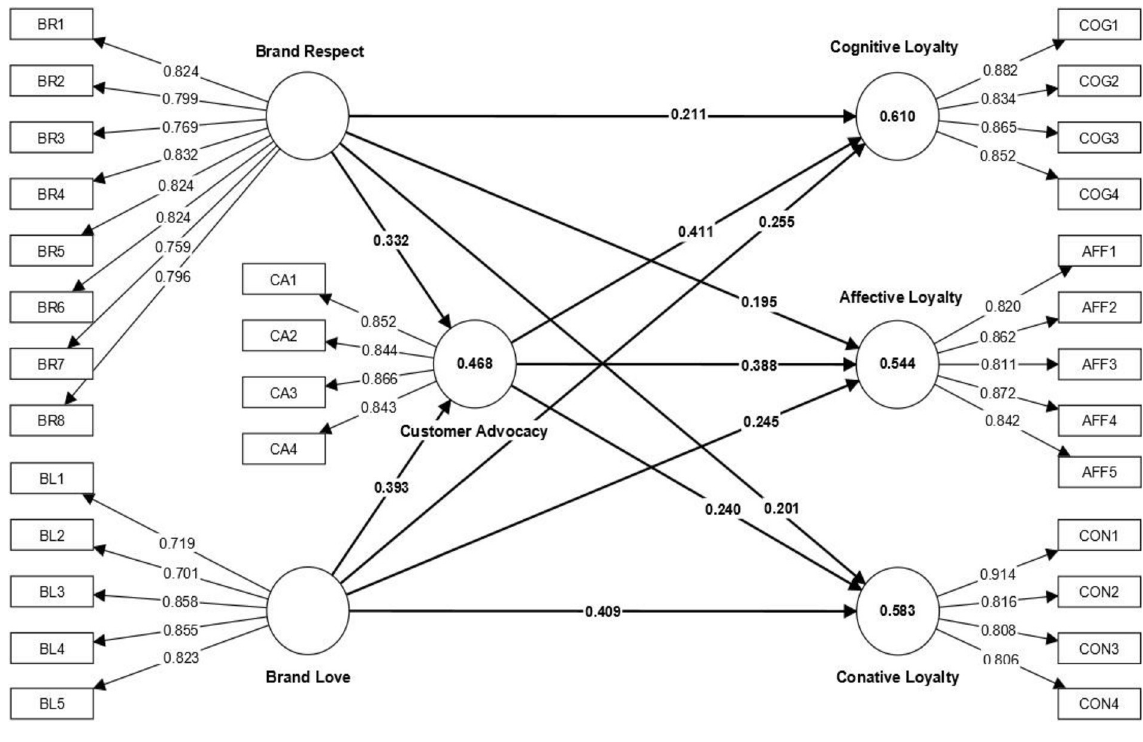
Fig 2. First-order